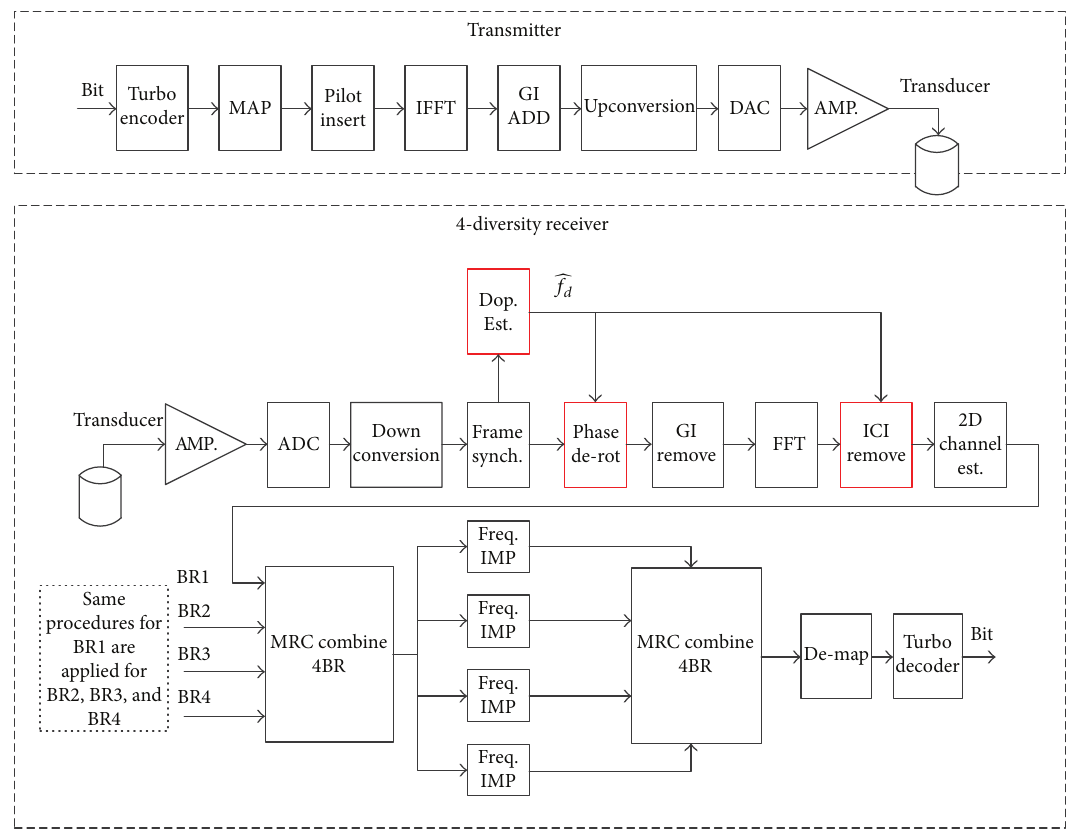
Figure 1: Proposed transceiver architecture.